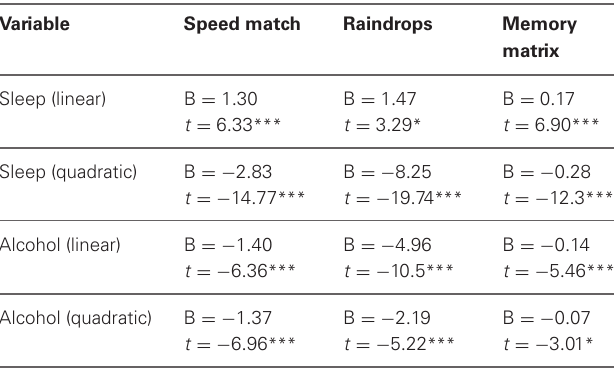
Table 1 | Model coefficients and t-statistics for the linear and quadratic effects of reported hours of sleep and alcohol intake, taken from the grand regression